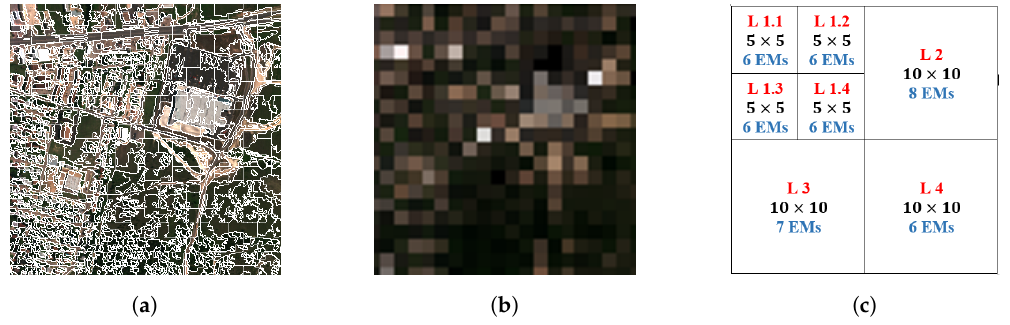
Figure 13. SLIC representation of the HYDICE Urban scene: ( a ) SLIC over-segmentation; ( b ) SP representation, each pixel replace by the mean; ( c ) partitioning of the SP representation using quadtree (EMs = Endmembers per